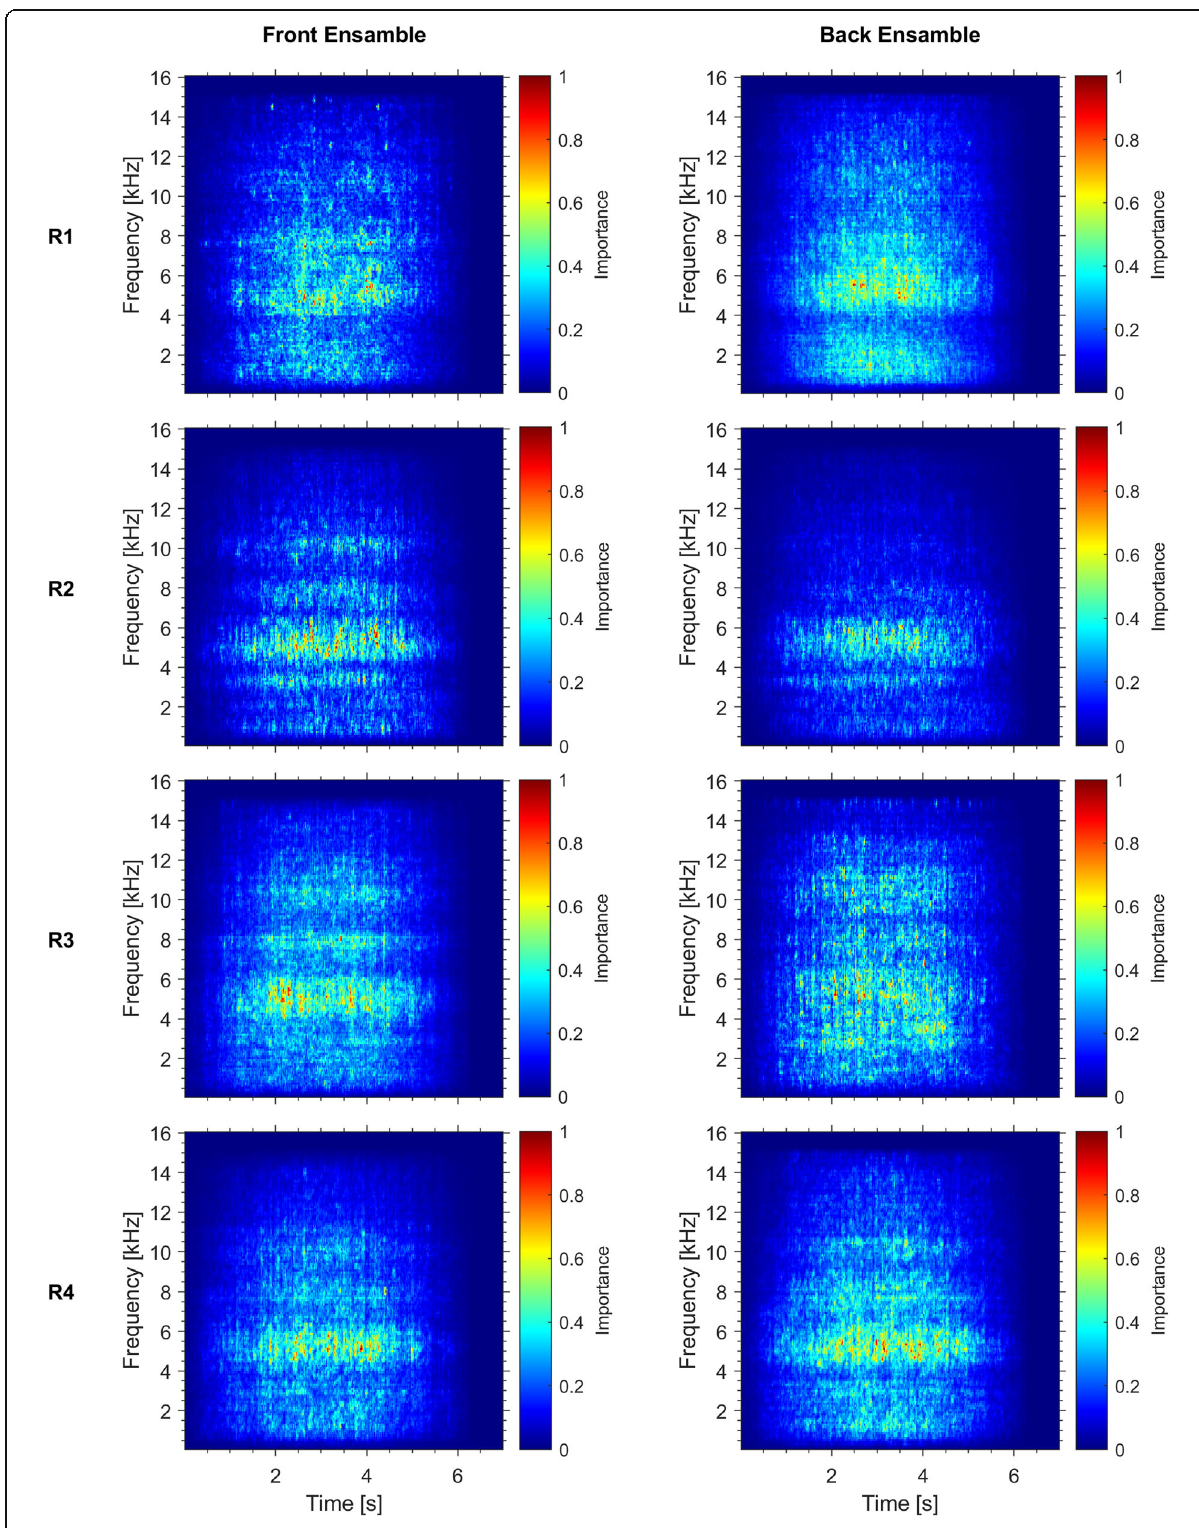
Fig. 17 Examples of the most important spectrogram regions identified using the GAM technique. The left and right columns represent the average importance maps for the front and back ensembles, respectively. The rows illustrate the results obtained with the same CNN for four separate experiment repetitions ( R 1, R 2, R 3, and R